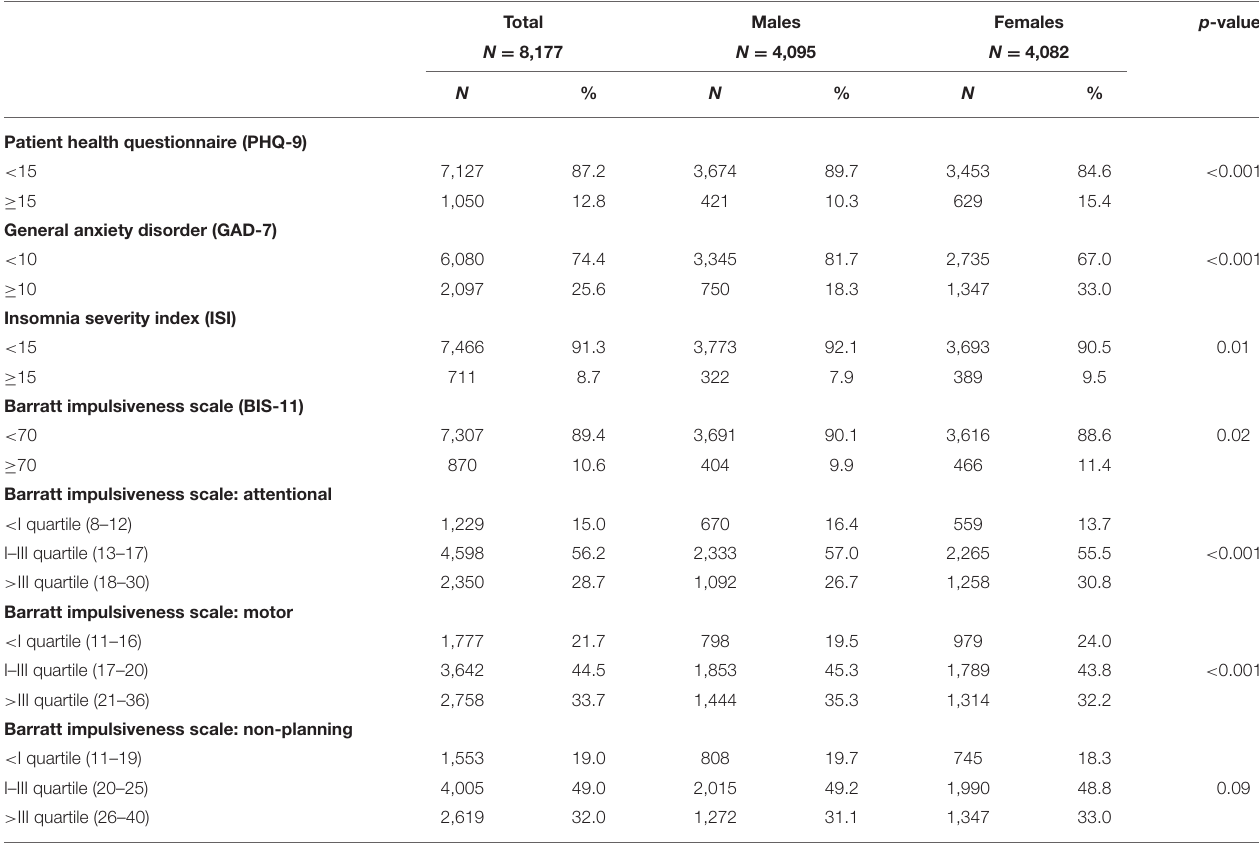
TABLE 1 | Distribution of 8,177 students according to the mental health outcomes and sex.